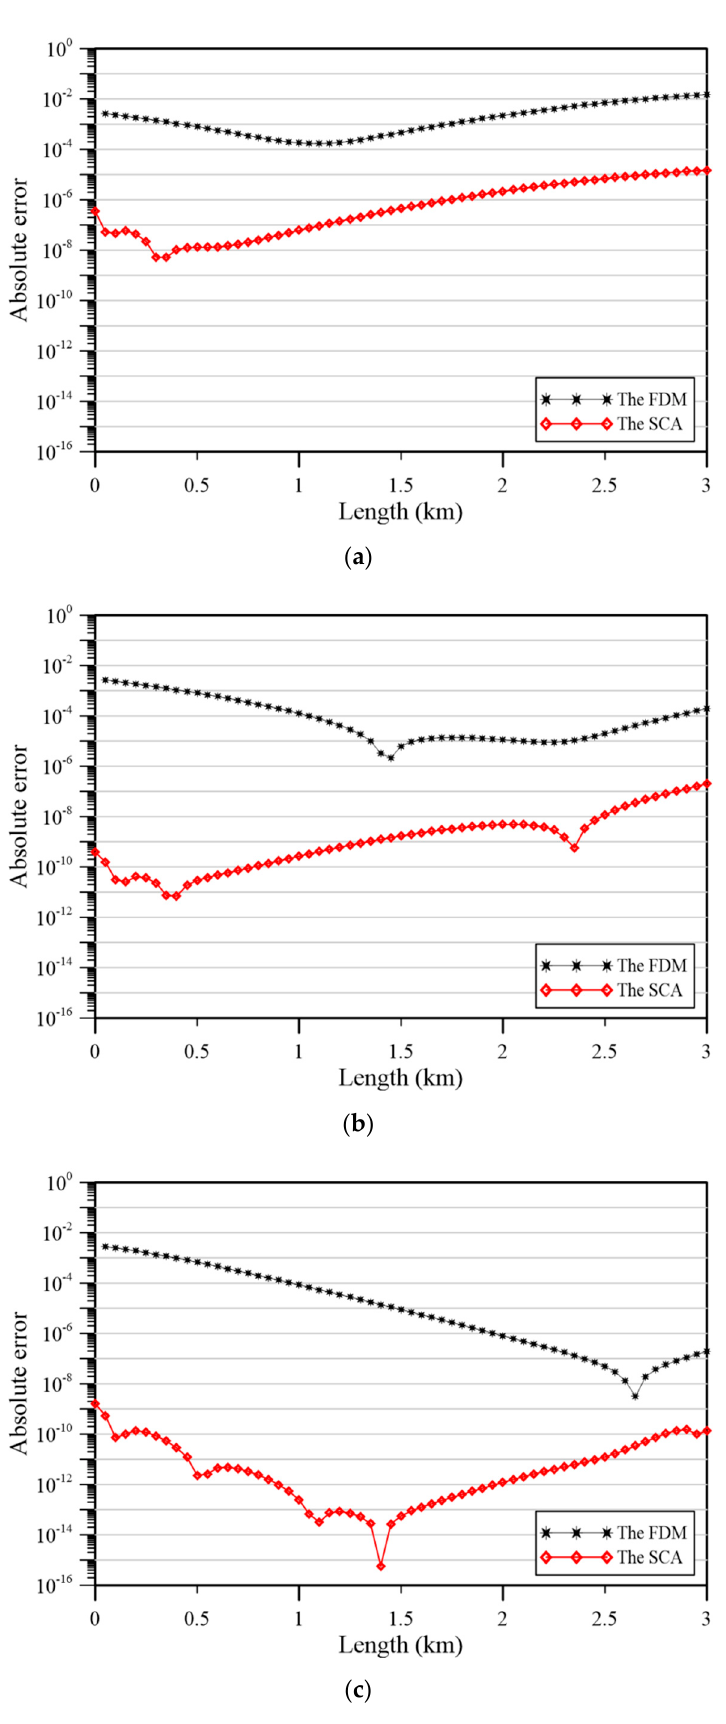
Figure 14. Comparison of the absolute error with the FDM and the SCA at tf = 3 hr: ( a ) L = 0.00/d; ( b ) L = 0.01/d; ( c ) L =